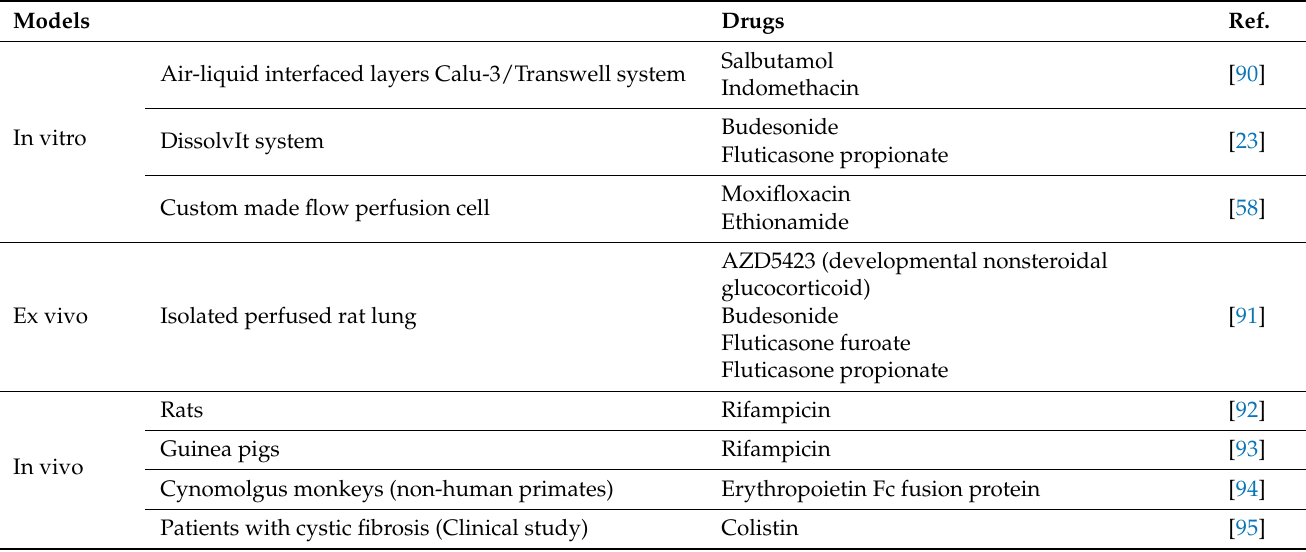
Table 4. Summary of various models for pulmonary drug